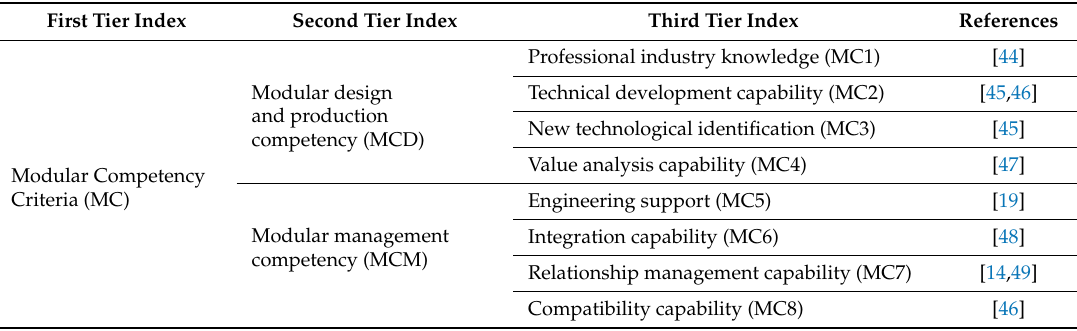
Table 2. Indexes of sustainable modular supplier